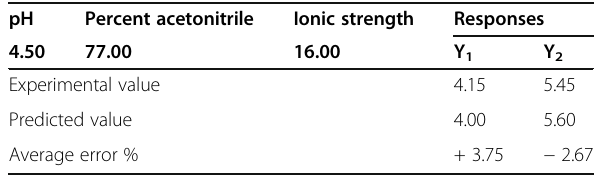
Table 6 Comparison of observed and predicted values of different objective functions under optimal